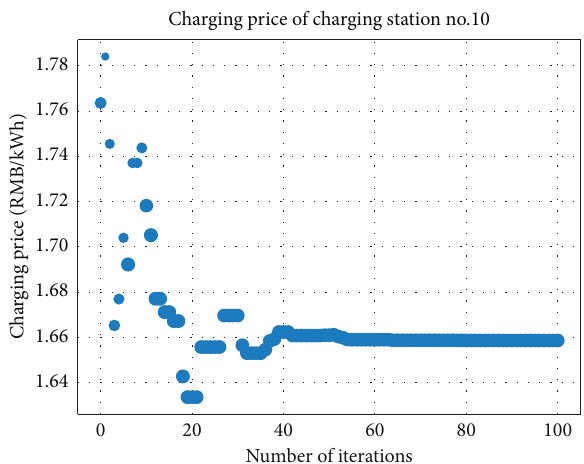
Figure 12: Charging price of charging station No. 10.